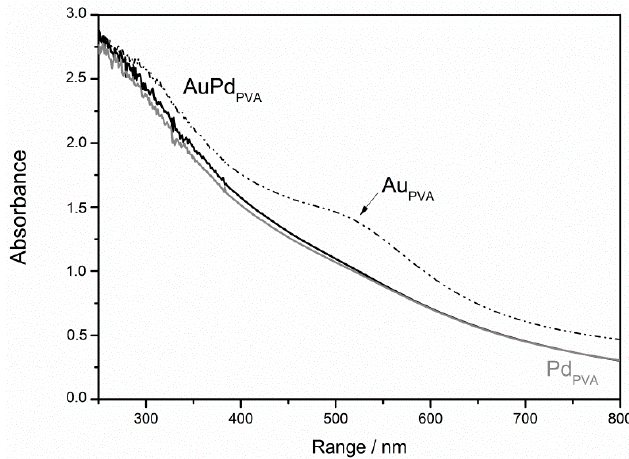
Figure 1. UV-vis spectra in H 2 O of Au PVA , Pd PVA and AuPd PVA nanoparticles.